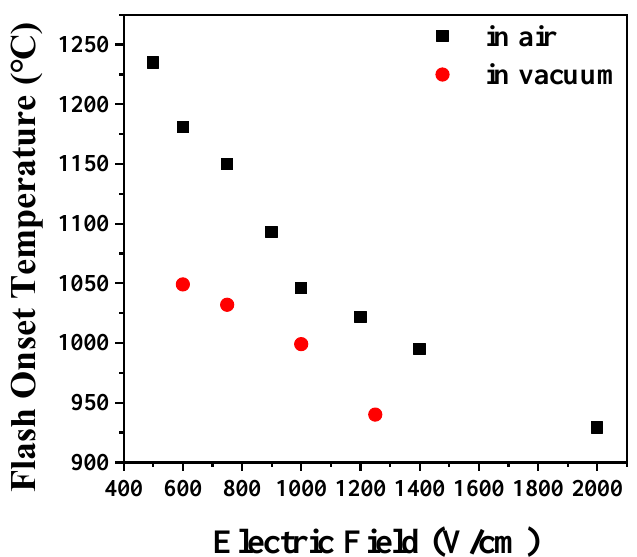
Figure 1. Change of flash onset temperature with electric field during flash sintering of hydroxyapatite.